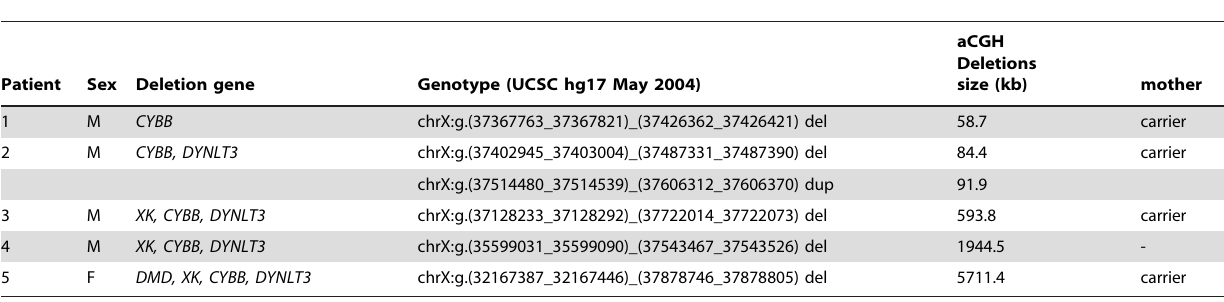
Table 1. The Results of aCGH Analysis of the Length of the Gene-Deleted Region and Disease Genes.